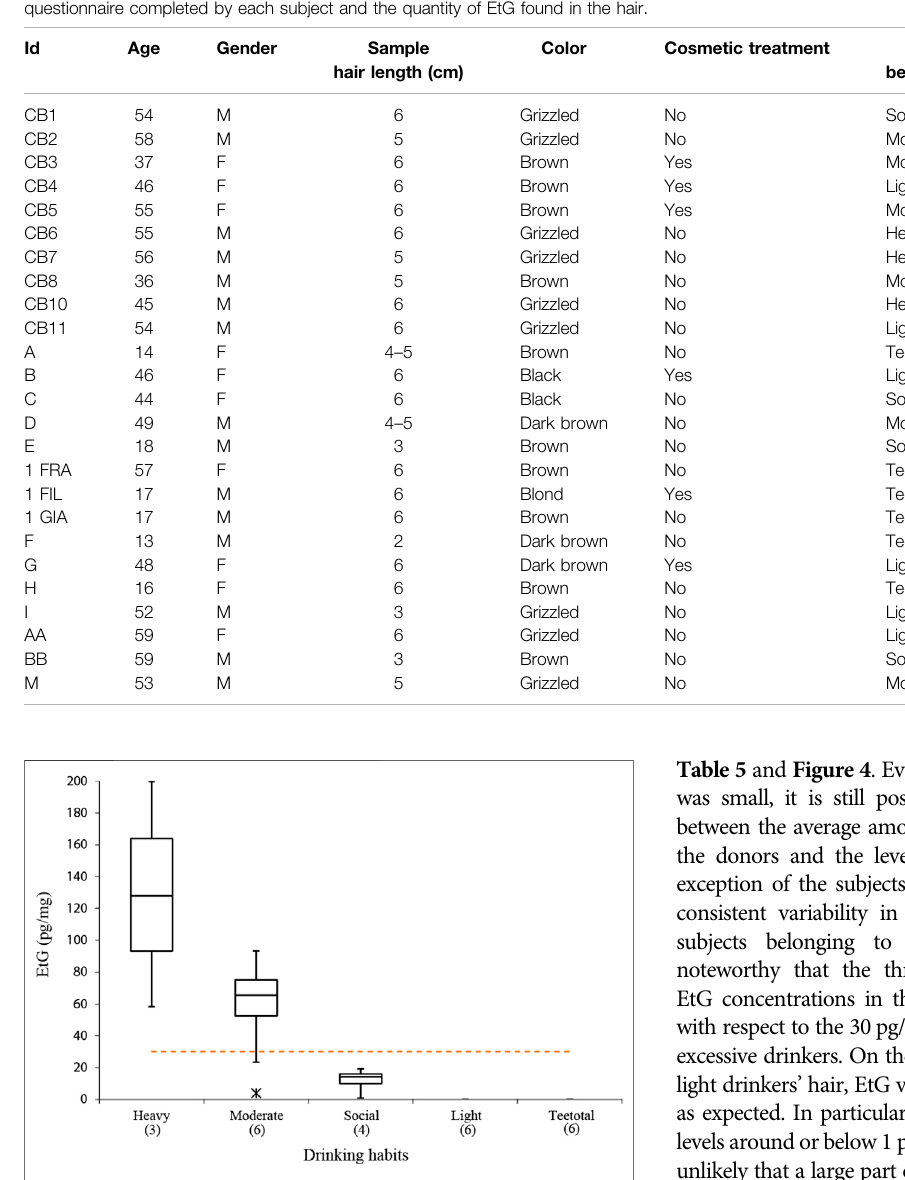
FIGURE 4 | Box and whisker charts of EtG detected in the subjects compared to the subdivision into classes of alcoholic habits obtained on the basis of the questionnaire completed by each donor subject. Dashed line represents the SoHT cut-off value of 30 pg/mg and asterisk represents the outlier values for CB2 and CB3. Numbers in brackets represent the number of subjects for each